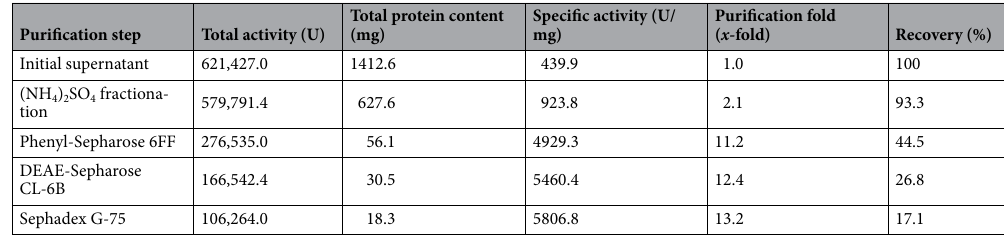
Table 1. Data of the purification stages for UcB5